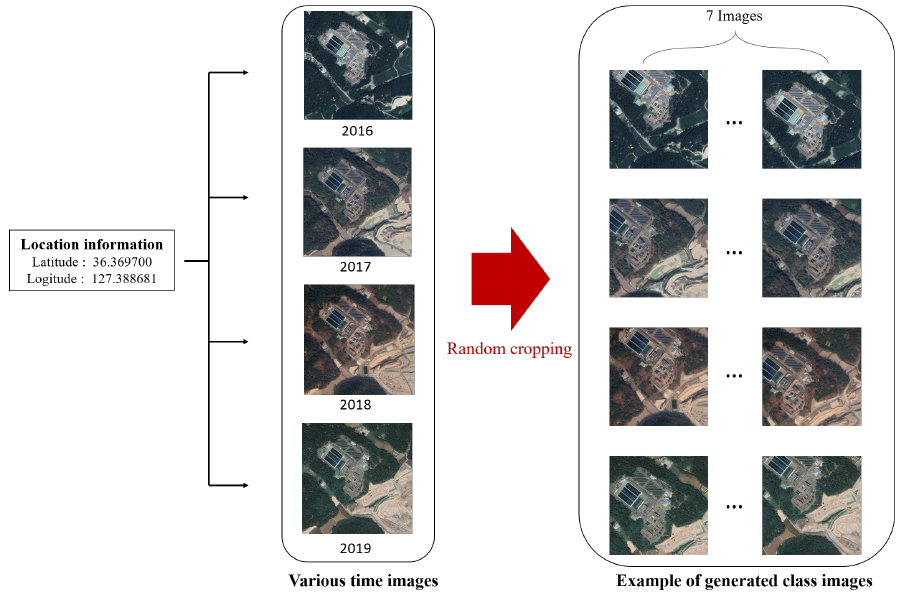
Figure 11. Illustration of the process of generating class images.